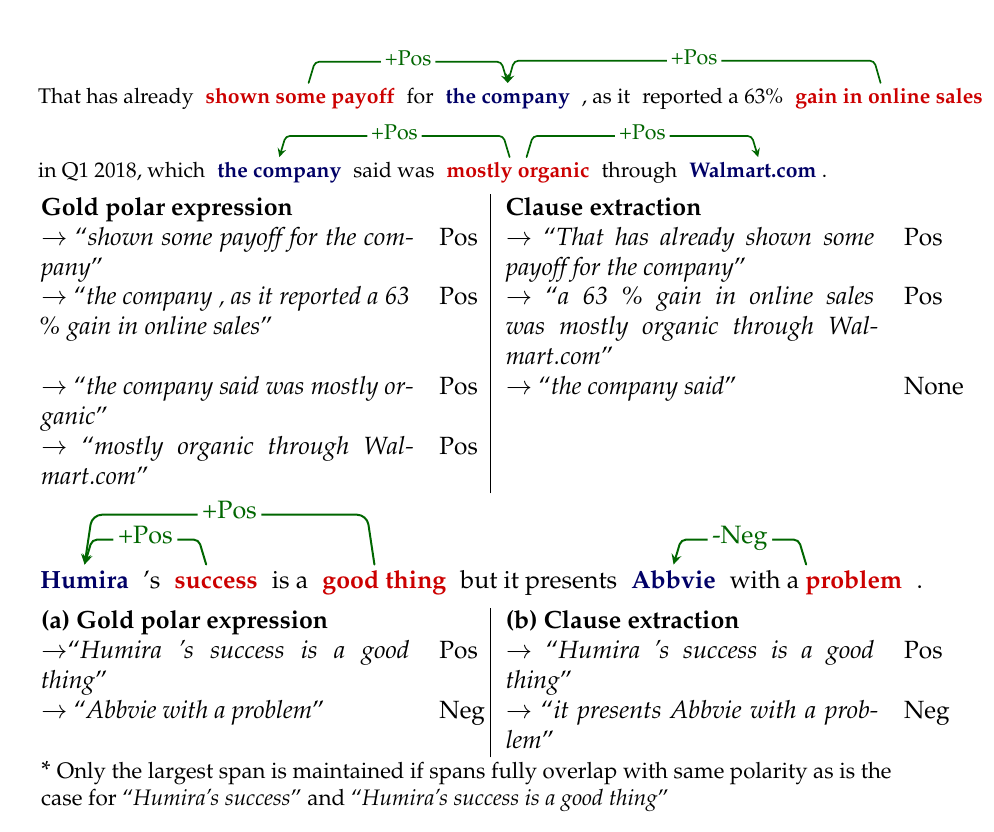
Figure 5. Fine-grained annotations to coarse-grained text inputs with label for ( a ) gold polar expres- sion (i.e., the labeled polar span and target span made continuous) and ( b ) clause-based experiments. For (b), we split the corpus sentences into sub-clauses using the OpenIE 5.1